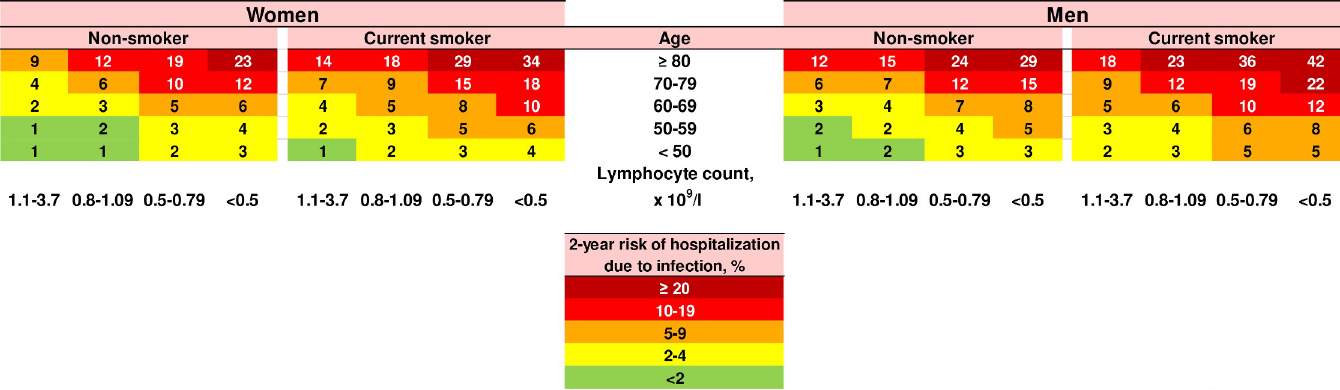
Fig 8. Algorithm. Absolute 2-year risks of hospitalization due to infection for different blood lymphocyte categories, stratified for age, sex, and smoking status. Nonsmokers were former smokers and never-smokers combined. Individuals diagnosed with immunodeficiency, hematologic disease, and/or autoimmune disease were not included when calculating absolute risks for the algorithm, since these individuals have a well-known high risk of infection. Numbers indicate absolute 2-year risk as rounded